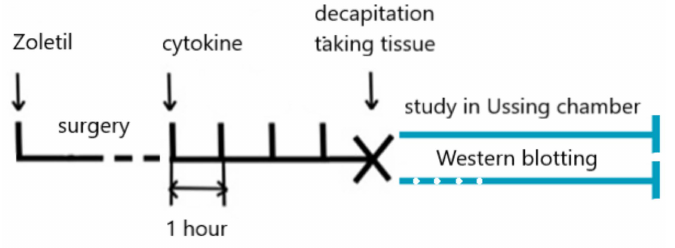
Figure 6. Design of experiment 2